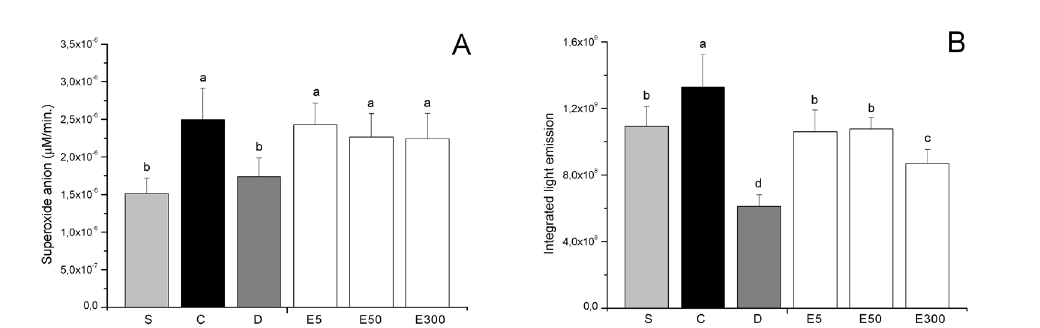
•- production by rats peritoneal neutrophils. Results are presented as means ± SD FIGURE 4 - A. Effect of the treatments on O 2 of seven determinations of the reduction of cytochrome C 100 μM by rats peritoneal neutrophils (2 x 10 6 cells per millilitre) stimulated with PMA (100 ng/mL). B. Effects of the treatments on ROS production. Results are presented as means ± SD of the integrated area of light emission obtained for the oxidation of luminol 1 mM promoted by rats peritoneal neutrophils (1 x 10 6 cells per millilitre) stimulated with PMA (53 ng/mL) from seven experiments of each group. S = saline group; C = carrageenan group; D = dexamethasone group; E5, E50 and E300 = extracts groups. Different letters indicate statistical significance